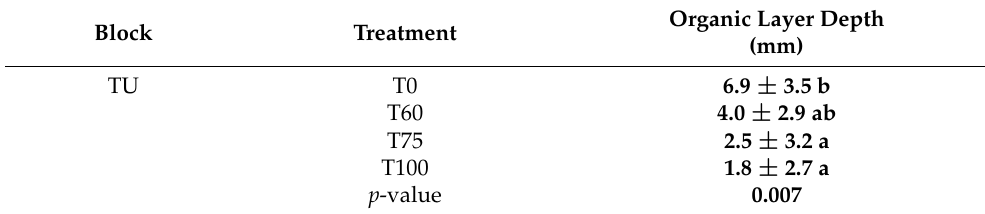
Table 2. Organic layer depth for each silvicultural